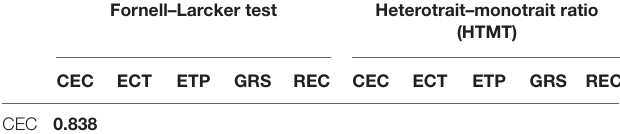
TABLE 5 | Path coefficients and statistical (HTMT)